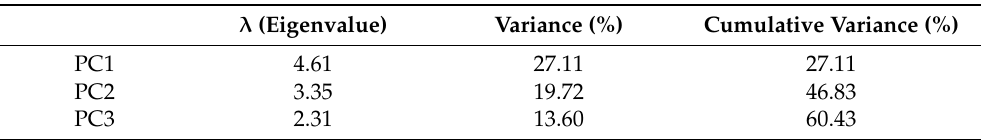
Table 2. Eigenvalues, percentage of variance explained by each principal component, and cumulative percentage of variance. Notice that the first three components were considered, since they were the components that explained most of the